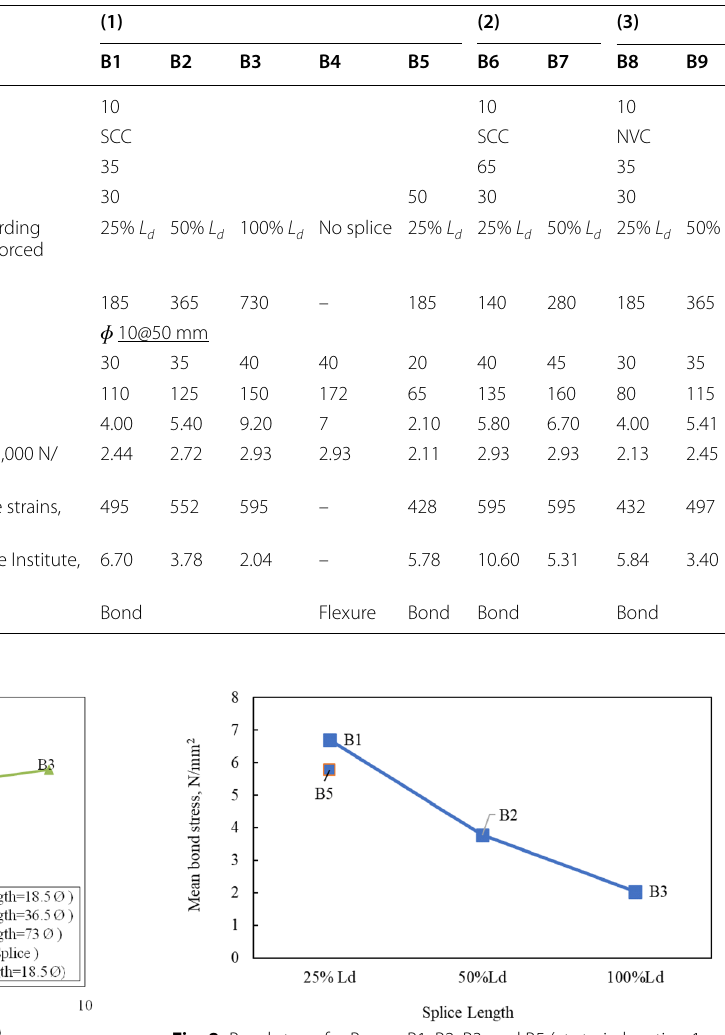
Fig. 8 Bond stress for Beams B1, B2, B3, and B5 (at strain location